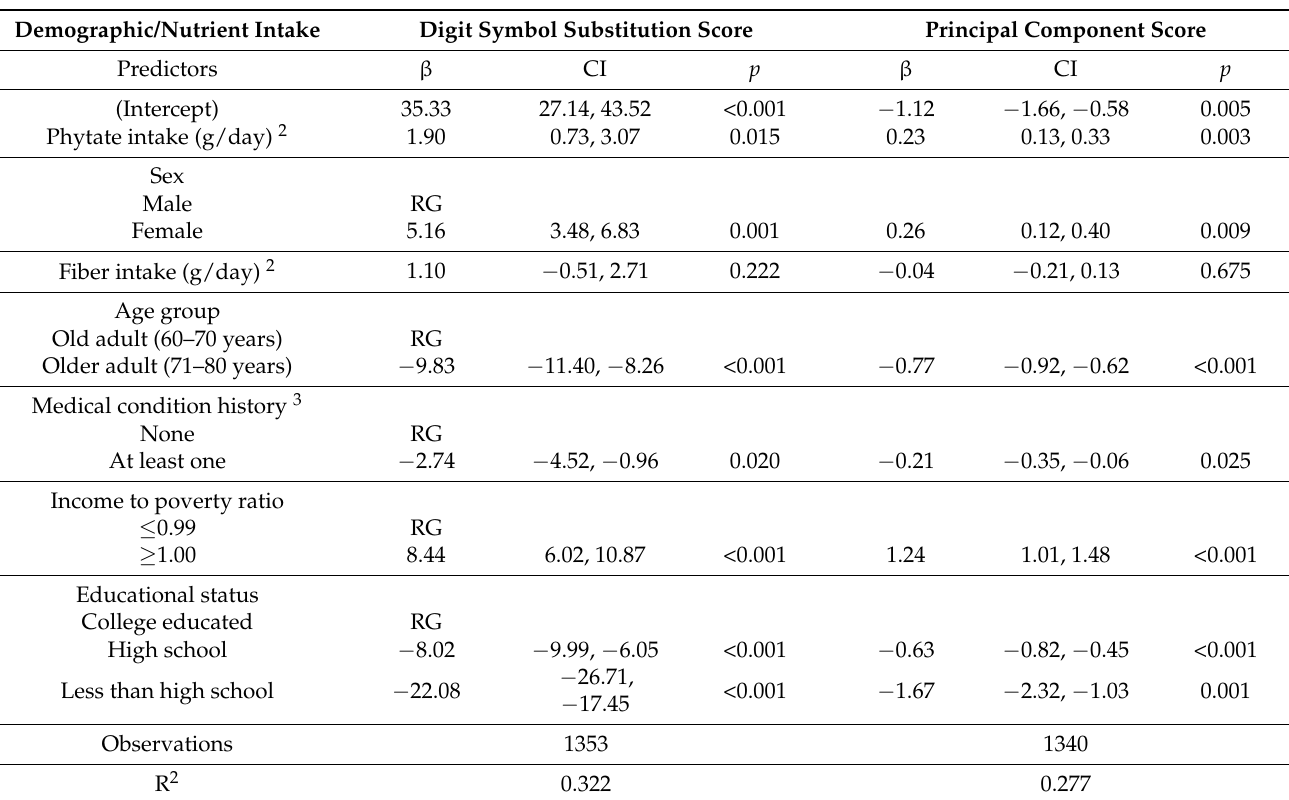
Table 3. Association between phytate intake and cognitive function (Digit Symbol score and first principal component score) among older adults 60–80 years old 1 .